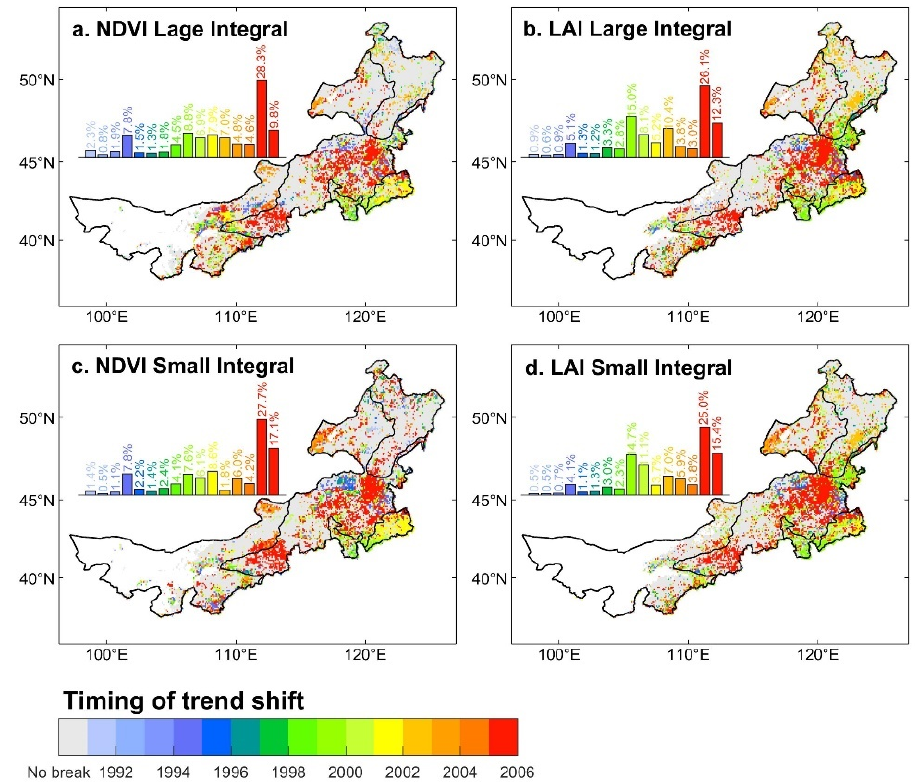
Figure 5. Spatial distributions of the timing of trend shifts, ( a ) NDVI large integral; ( b ) LAI large integrals; ( c ) NDVI small integral; ( d ) LAI small integral. Pixels with no breakpoint are reported in grey while white areas indicate regions with no data (i.e., non-vegetated areas or missing data). The histograms above each map summarize the distribution of the timing of breakpoints (calculated as the proportion of the number of breakpoints per year to the total pixels of all breakpoints).